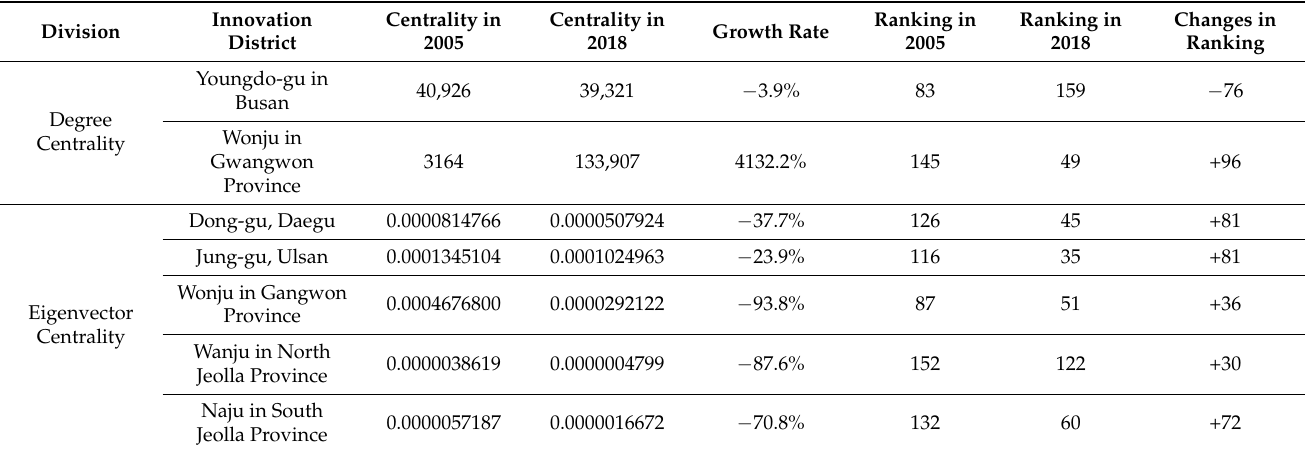
Table 6. Prominent changes in the centrality of Innovation Cities under